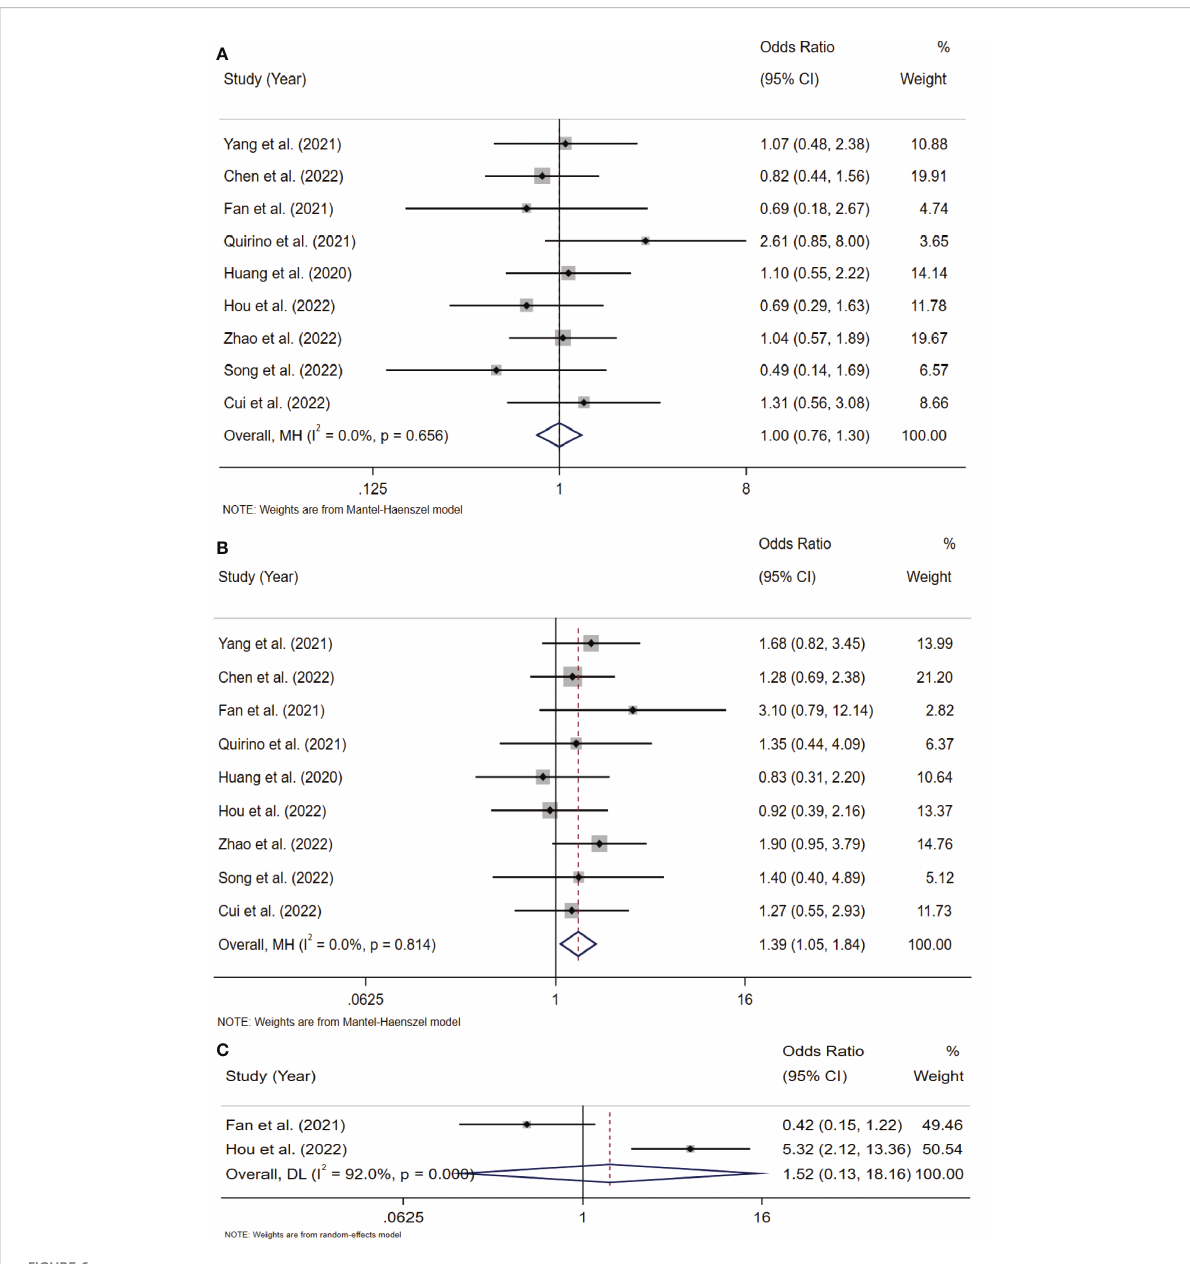
FIGURE 6 Forest plots of Siglec-15 expression and clinicopathological features in solid tumor. (A) Age (> 50 years old vs . < 50 years old); (B) Gender (male vs . female); (C) distant